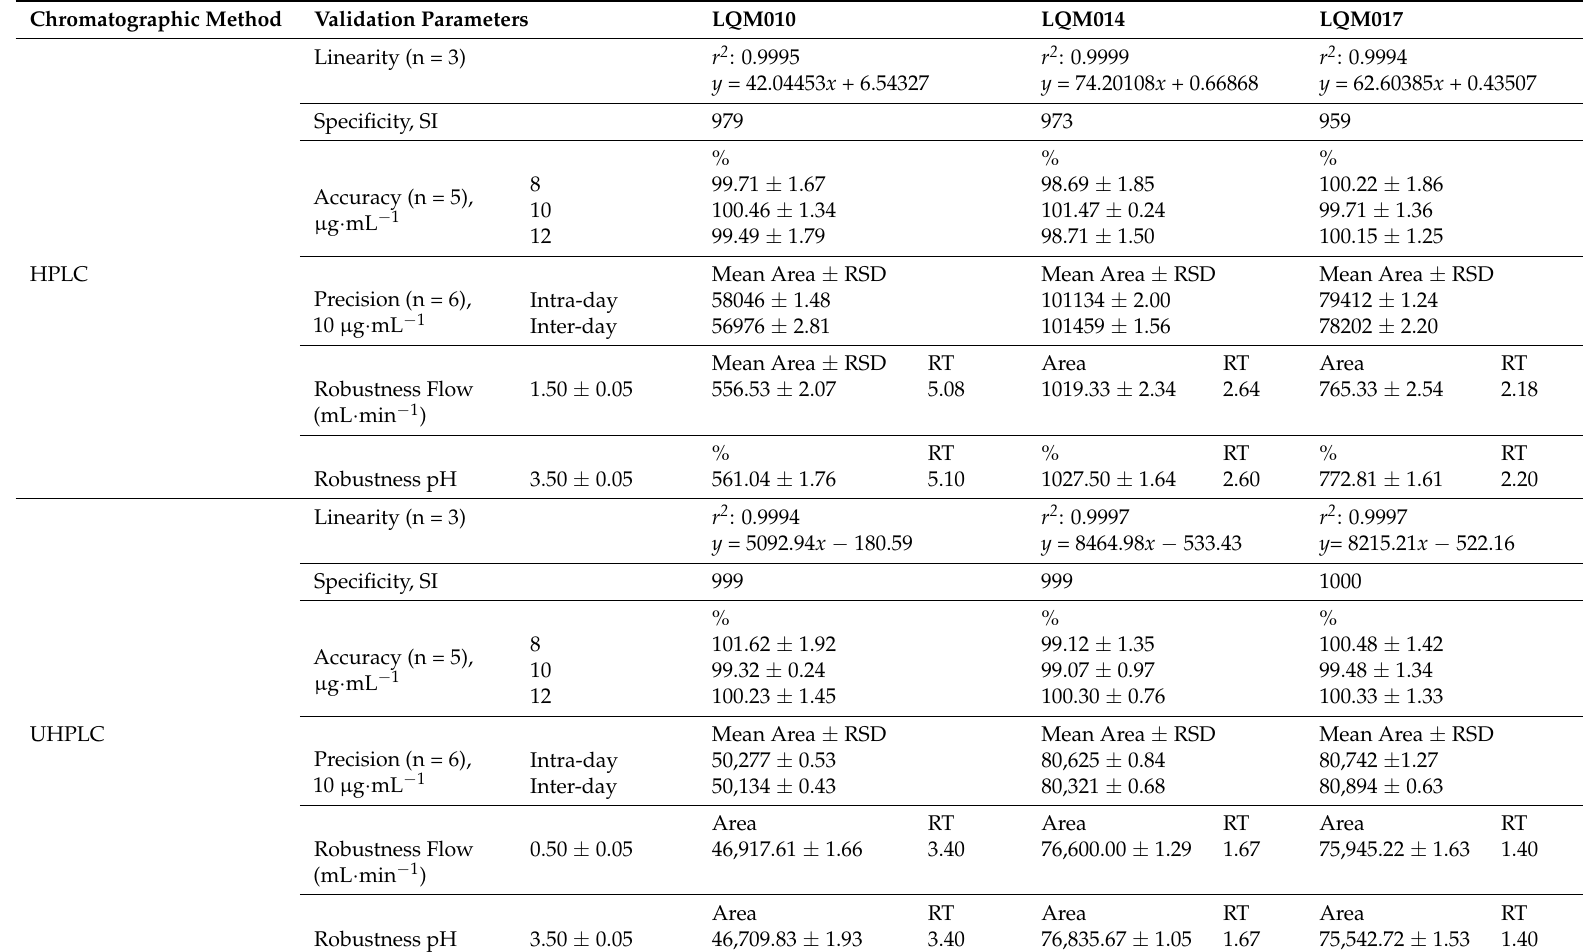
Table 1. Validation results of HPLC-DAD and UHPLC-DAD method for determination of guanylhydrazone derivatives. Chromatographic